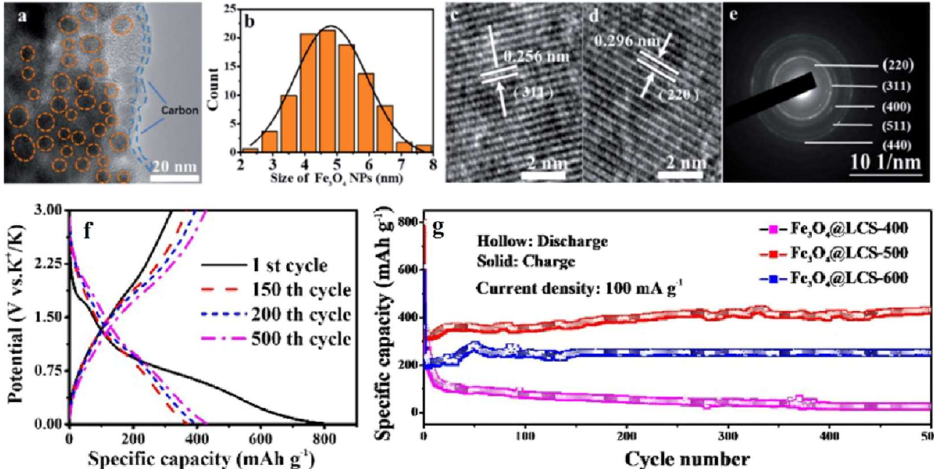
Figure 11. ( a ) High resolution transmission electron microscopy (HRTEM) image of the Fe 3 O 4 @LCS- 500 composite highlighting an apparent amorphous carbon layer and a multitude of Fe 3 O 4 nanodots. ( b ) Size distribution of the small Fe 3 O 4 nanoparticles, indicating an average size of about 5 nm. HRTEM close-up images ( c , d ) showing the crystal fringes and associated crystallographic planes of Fe 3 O 4 . ( e ) Selected area electron diffraction (SAED) pattern with indexed diffraction rings for the series of diffracting crystalline planes. ( f ) Galvanostatic discharge/charge voltage profiles for some selected cycles of Fe 3 O 4 @LCS-500 cycled in a K half-cell at 100 mA g − 1 between 0.01 V an 3.00 V. ( g ) Cycle performance and capacity retention of the same K half-cell with Fe 3 O 4 @LCS-500 compared to those of Fe 3 O 4 @LCS-400 and Fe 3 O 4 @LCS-600, respectively. Note in ( f ) and ( g ) a